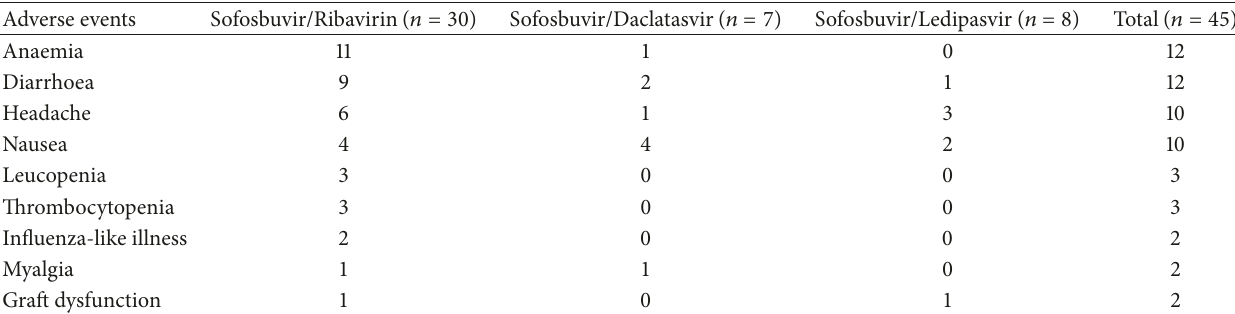
Table 4: Adverse events reported while on DAA therapy.